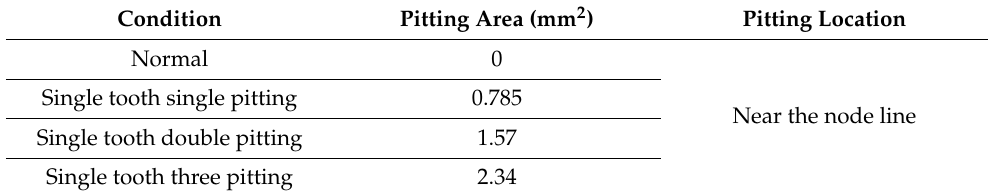
Table 5. Experimental gear example.